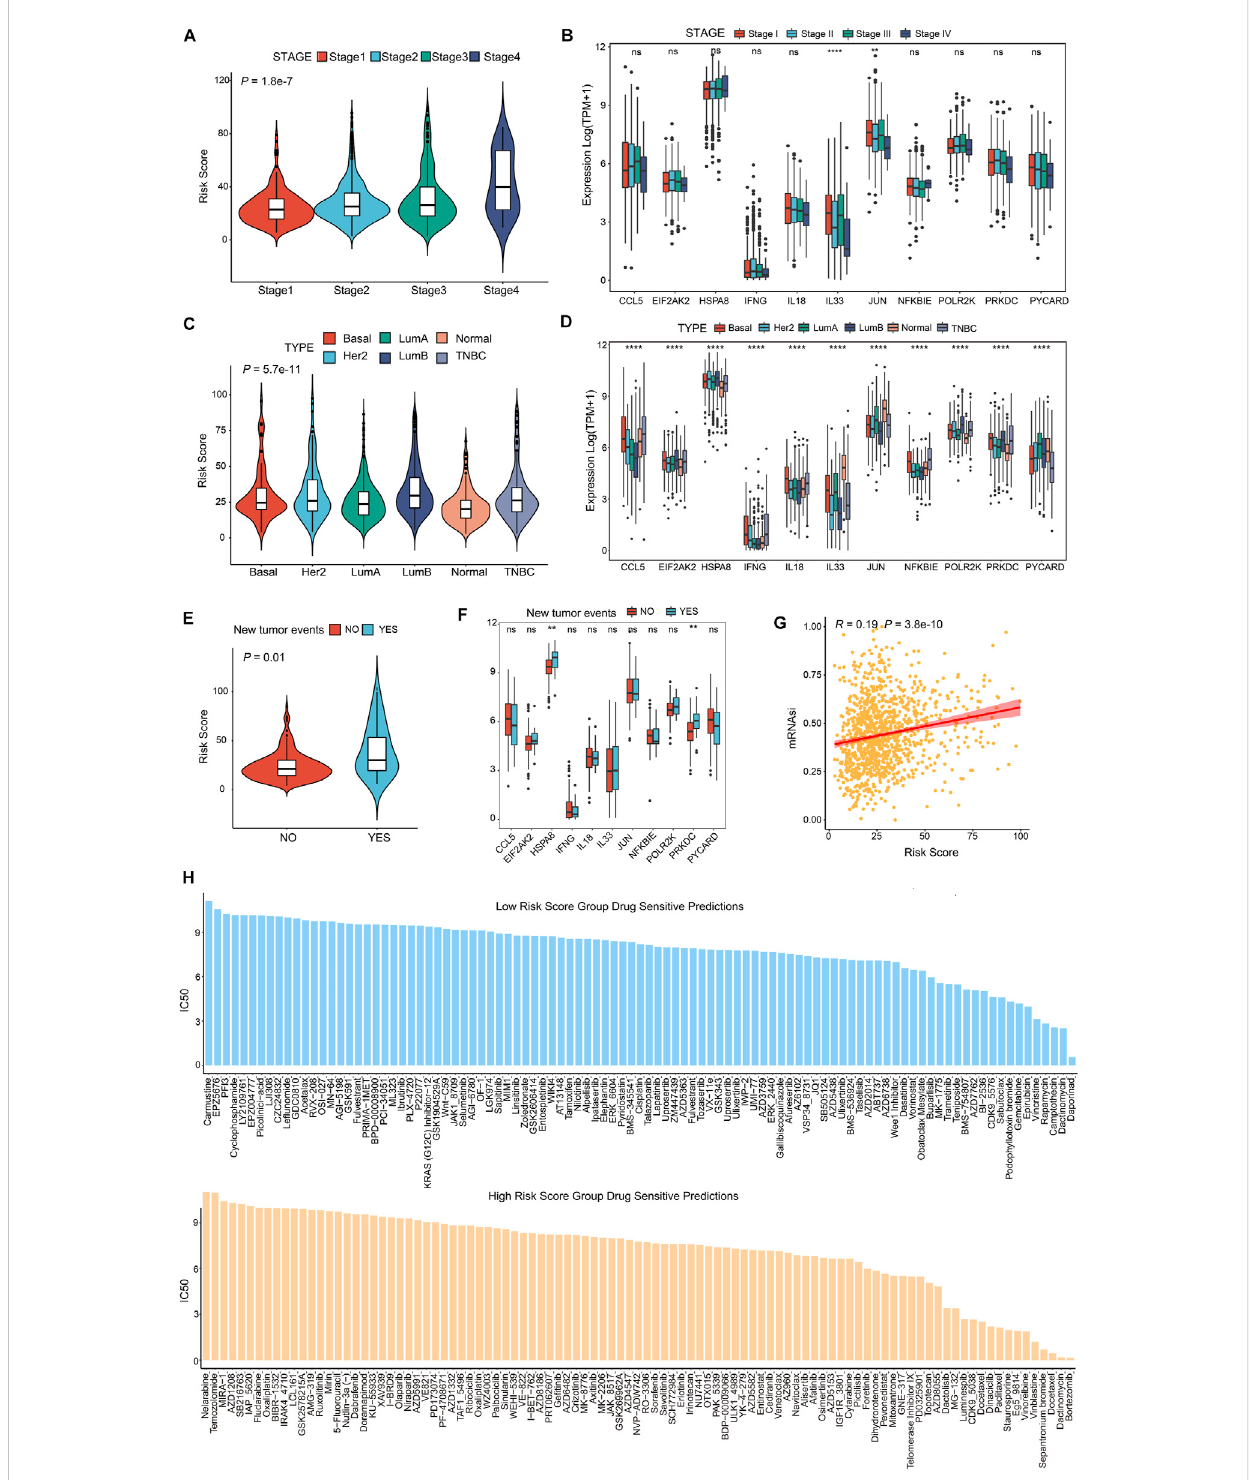
FIGURE 7 CSRGs risk score predicted clinical therapeutic bene fi ts ofBRCA patients. (A) Violin plotshowed theassociation betweenrisk score and four clinical stages (stage 1, stage 2, stage 3 and stage 4). (B) The differentexpression levels of 11prognosis-related CSRGs in four stages was presented by a box plot. (C) ViolinplotdescriptedtherelationshipbetweenriskscoreandthemolecularsubtypesofBasal,Her2 + ,LuminalA,LuminalB,NormalandTNBCinBRCA patients. (D) The different expression levels of 11 prognosis-related CSRGs in six subtypes were described by box plot. (E) Violin plot displayed the correlation between the risk score and tumor recurrence in BRCA patients. (F) The different expressions levels of each 11 prognosis-related CSRGs in primary tumor and recurrent tumor were displayed by box plot. (G) CSCs detected the possibility of tumorigenesis in the low-risk score and high-score groups. (H) Histogram showed the drug sensibility in the low-risk score and high-score groups for BRCA patients. ** p < 0.01; **** p < 0.0001; NS, not signi fi